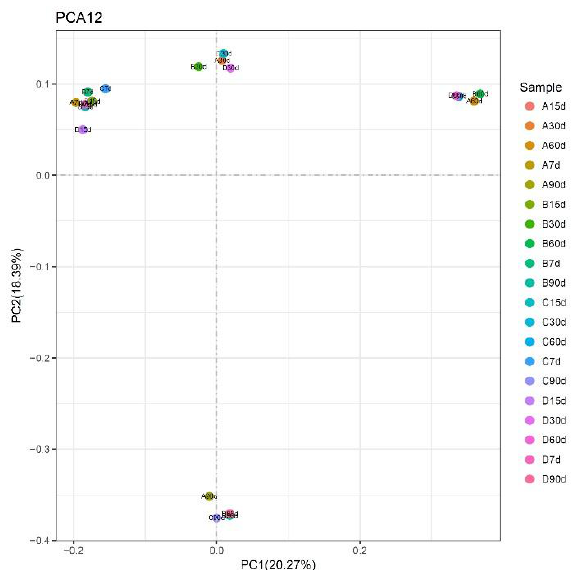
Figure 3. Principal component analysis (PCA) analysis of soil bacterial communities under different graphene treatments (A: 0 mg kg −1 ; B: 10 mg kg −1 ; C: 100 mg kg −1 ; D: 1000 mg kg −1 ; 7, 15, 30, 60, and 90 d mean 7, 15, 30, 60, and 90 days, respectively).